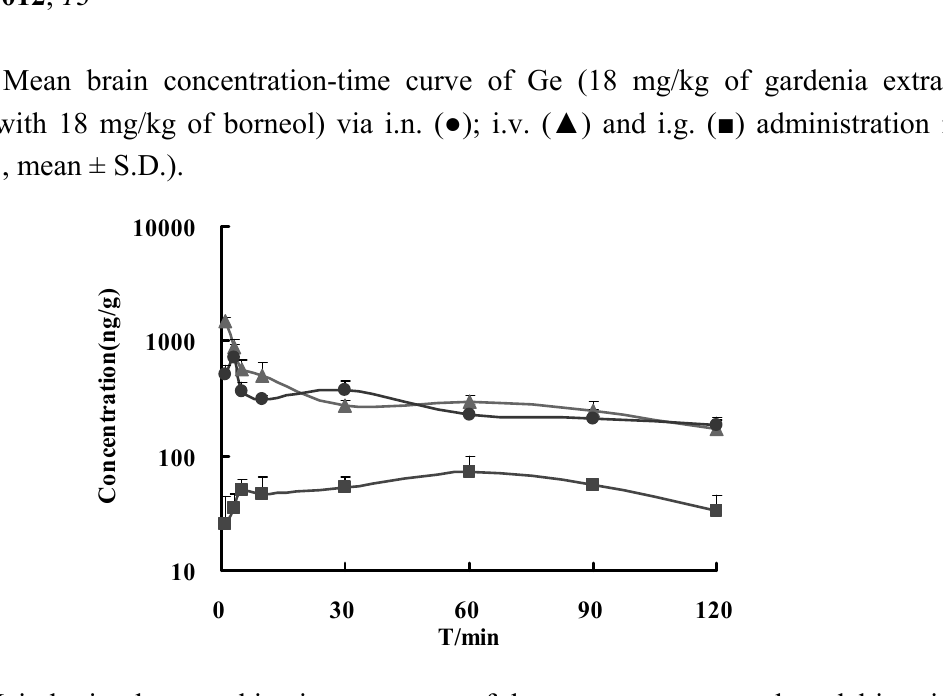
Table 2. Main brain pharmacokinetic parameters of the non-compartmental model in mice after i.n., i.v. and i.g. administration. Group